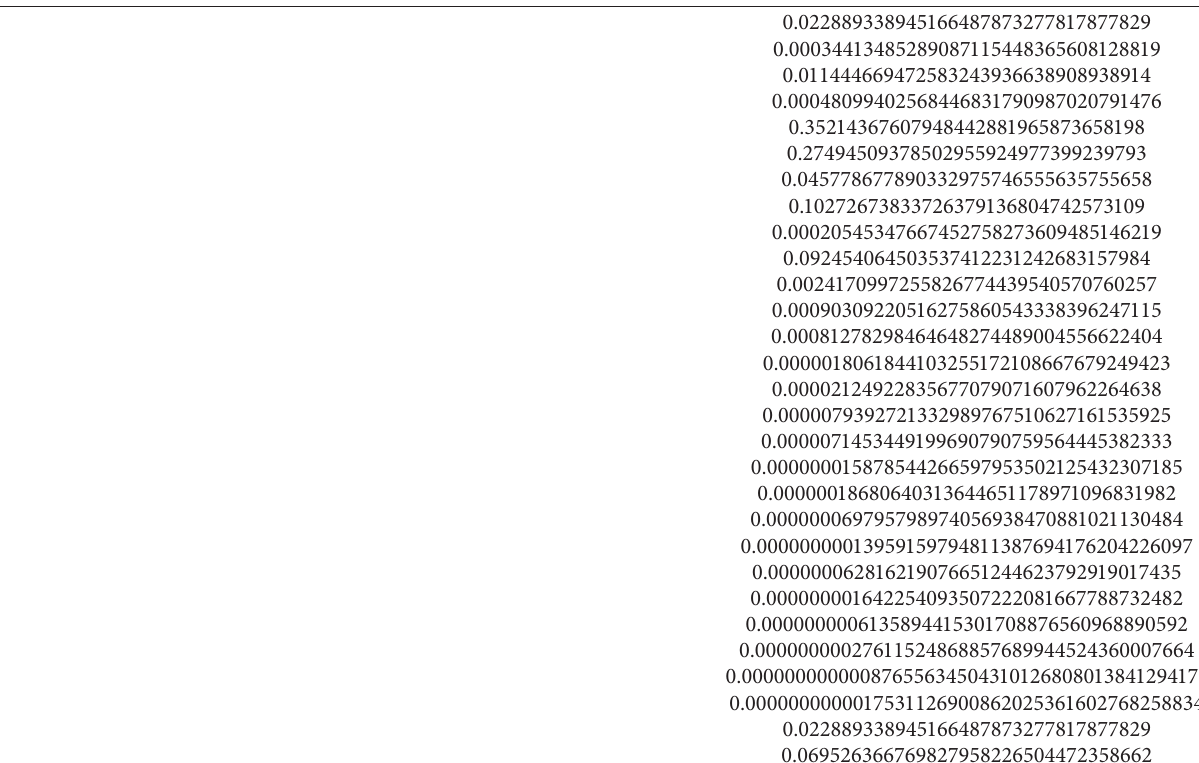
Table 6: Vector of the probability distribution of states: case study.